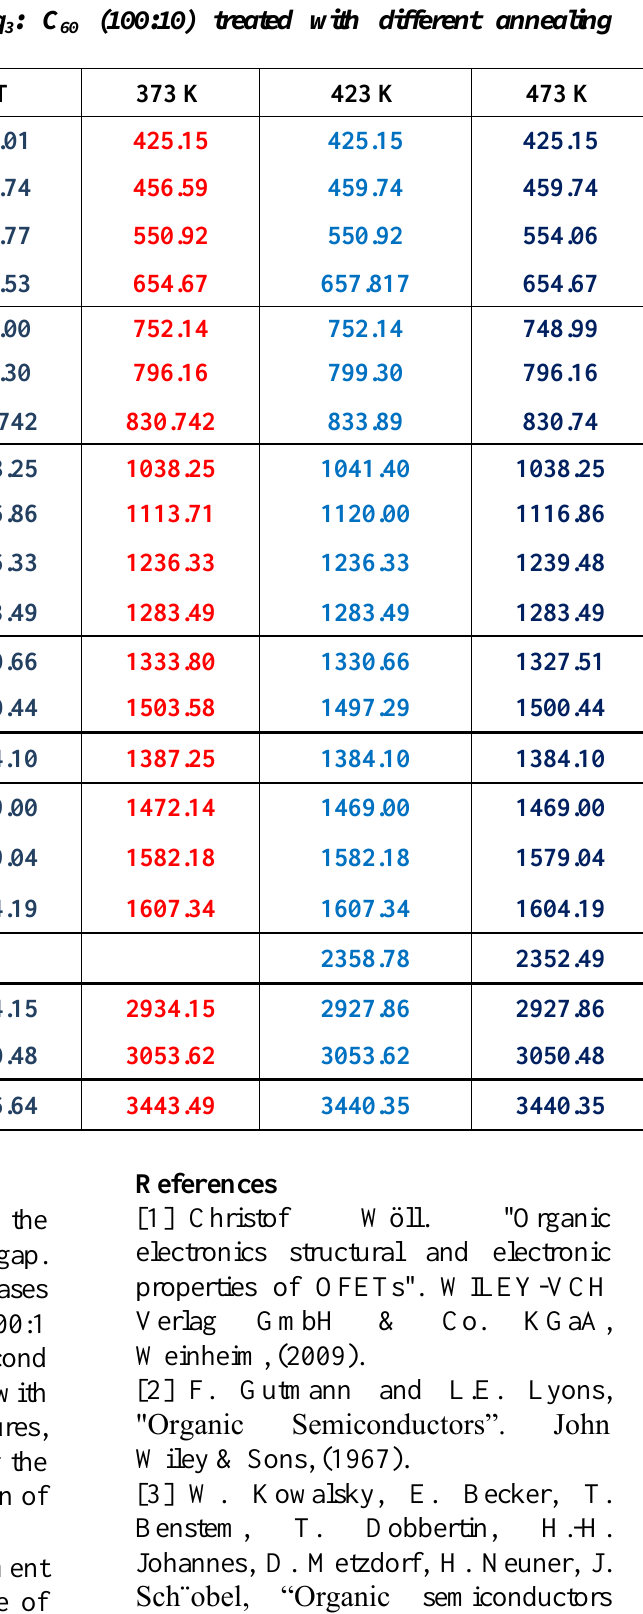
Table 3: FTIR bonds in for Alq